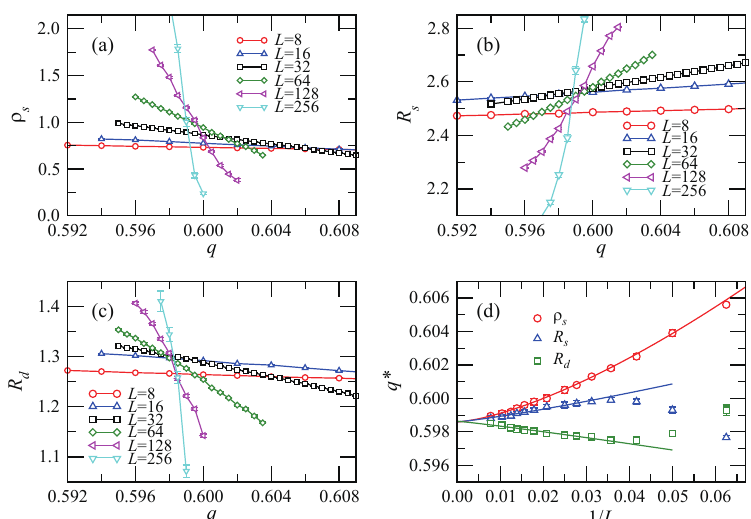
L (a), R model for ρ (b) and R s s d 3 = 0.59865 ( 5 ) for R , and q . s c d